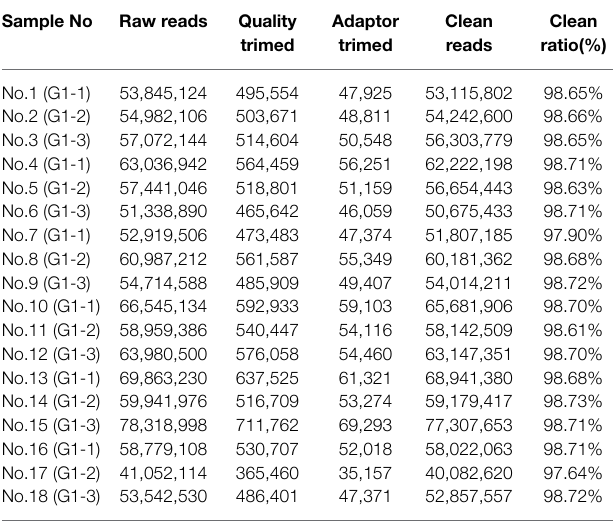
TABLE 1 | A statistics of data preprocessing